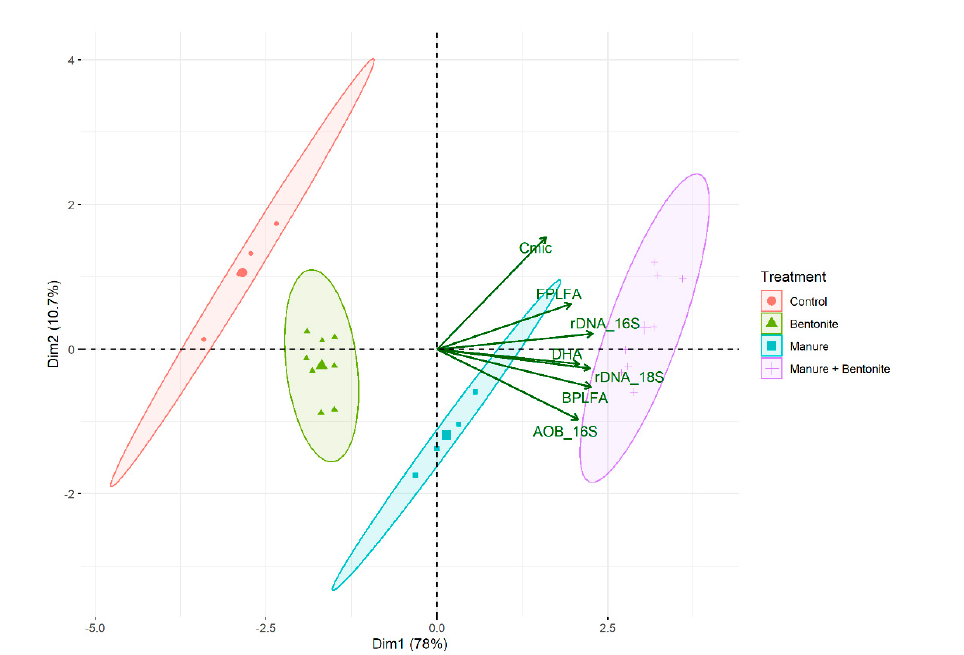
Figure 2. Pearson’s correlation matrix of the soil microbial properties.